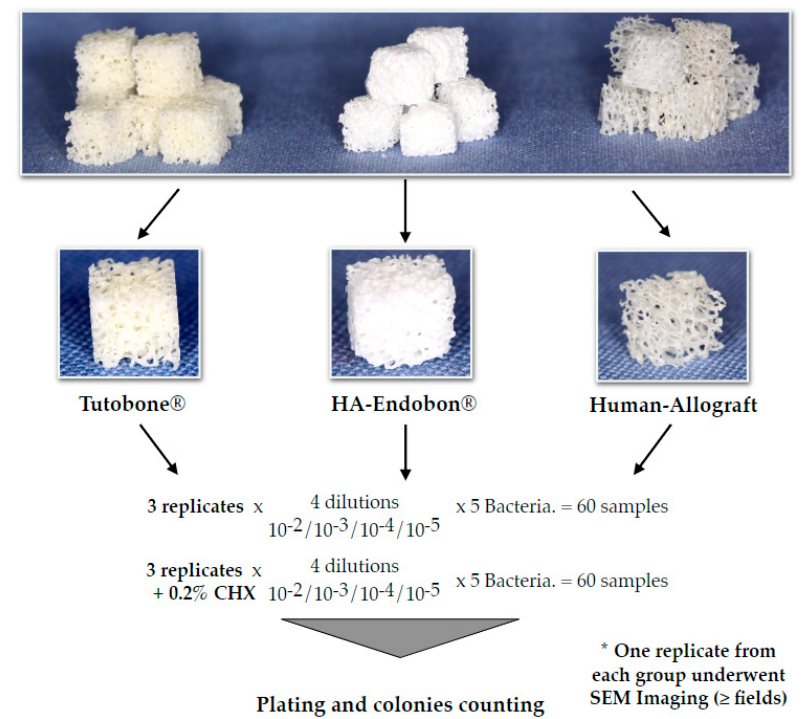
Figure 2. Depiction of the experimental flow diagram. The experiments for each bacterium and bone graft group were repeated three independent times. In total, 360 cube-shaped samples of the three different grafting materials were used to evaluate the bacterial growth on bone, in the presence or absence of chlorhexidine (CHX) solution in a quantitative pattern.